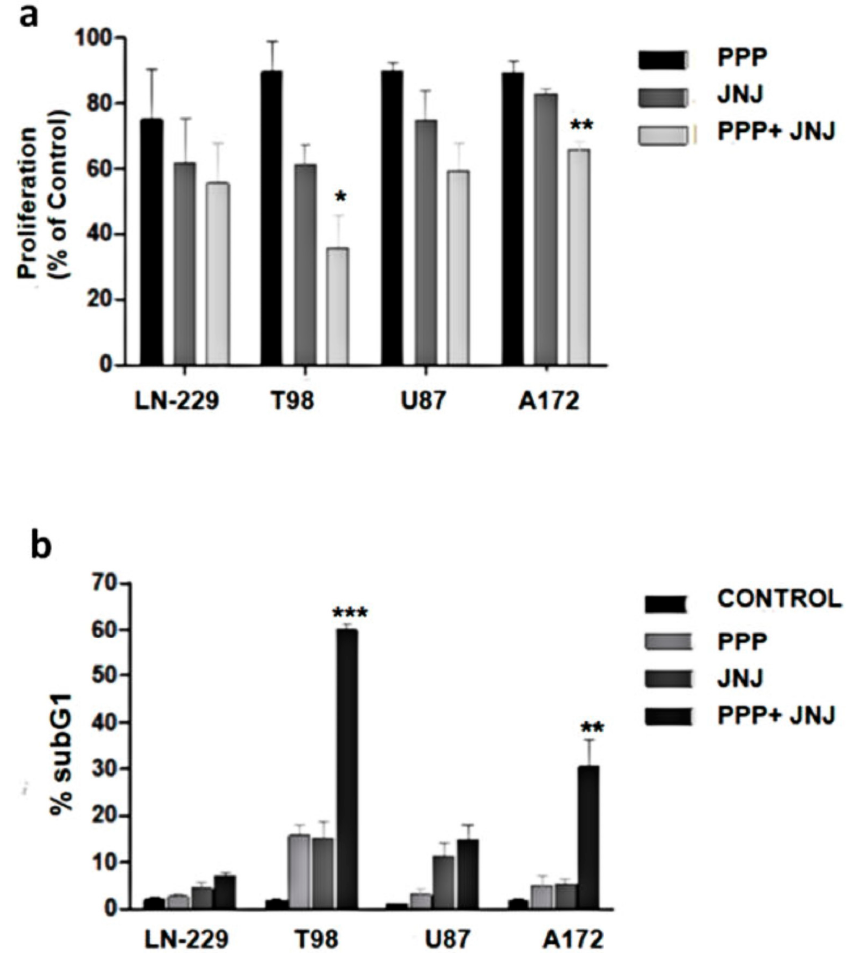
Figure 8. Combined effects of JNJ and PPP. ( a ) Effects on cell proliferation. GBM cells were seeded in 96-well plates, non-treated, or treated with 20 JNJ, 200 nm PPP or both for 72 h and cell